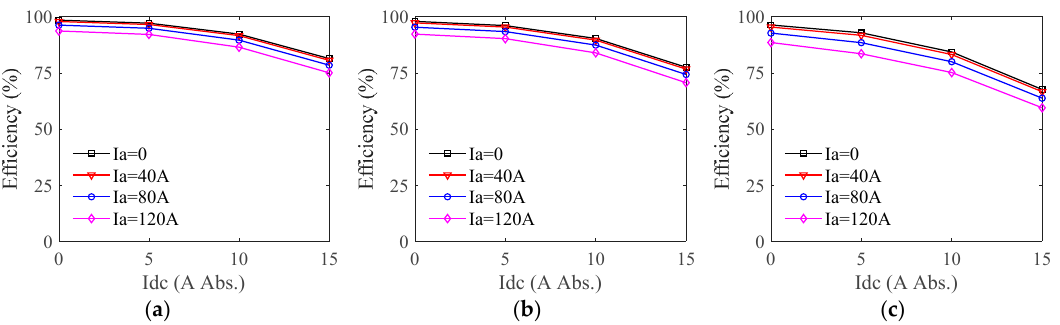
Figure 12. Evolution of efficiency as armature winding currents under different PRs at rated speed. ( a ) PR of 8/1. ( b ) PR of 17/1. ( c ) PR of 35/1.